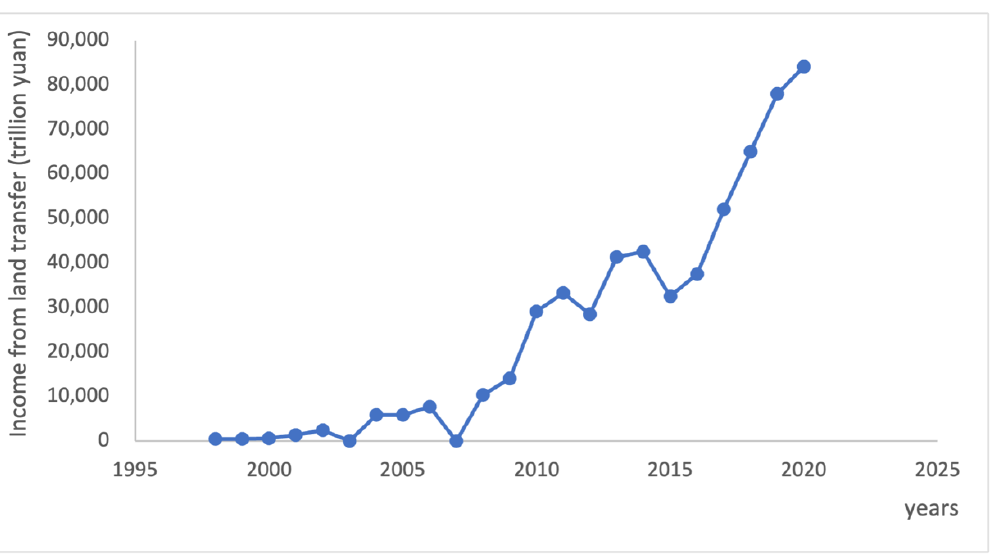
Figure 1. Local government land revenue in China, 1998 – 2021. Data source: Compiled according to the 1998 – 2020 China Land and Resources Statistical Yearbook .